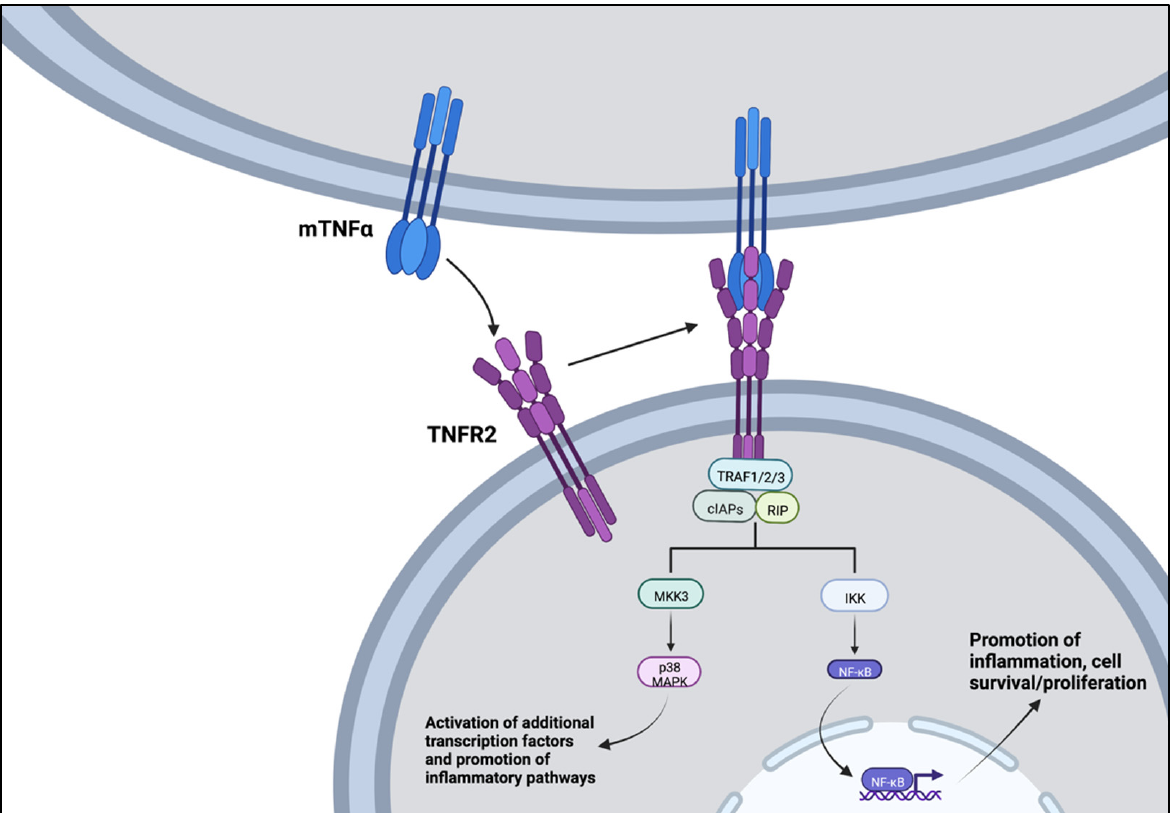
Figure 1. Activation of TNFR2 via membrane-bound TNF α (mTNF α ). After activation of the TNFR2 receptor, a signal transduction complex formed by TRAF (1/2/3), cIAP(1/2), and RIP. The downstream pathways promote cell proliferation, cell survival, and tissue regeneration. Image created using BioRender.